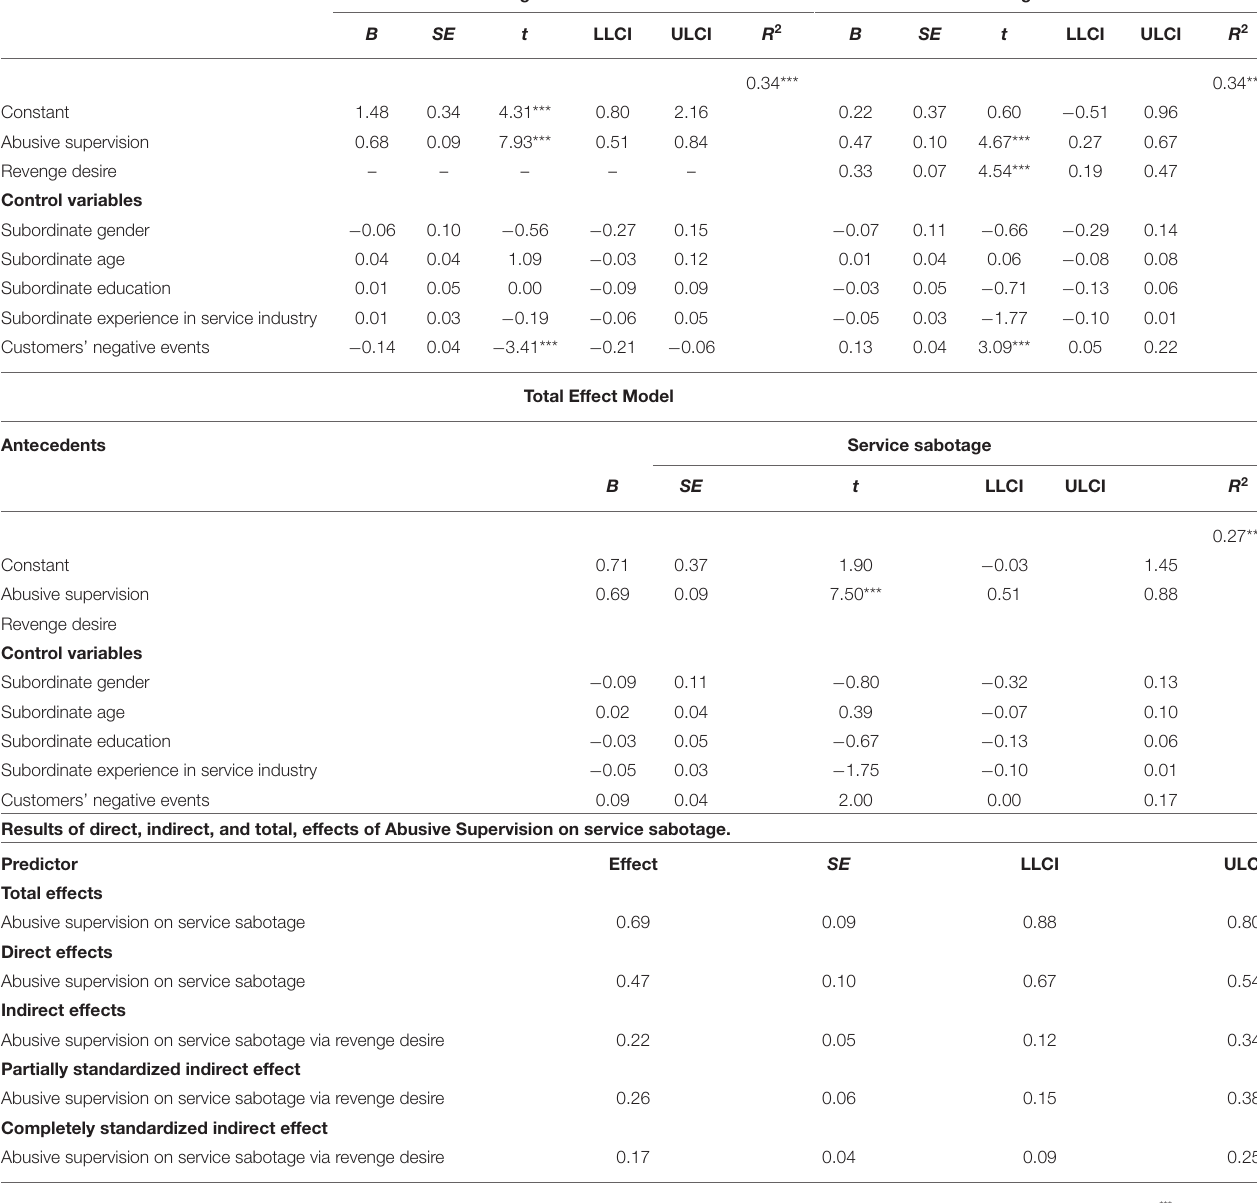
TABLE 2 | Results of mediation analysis.